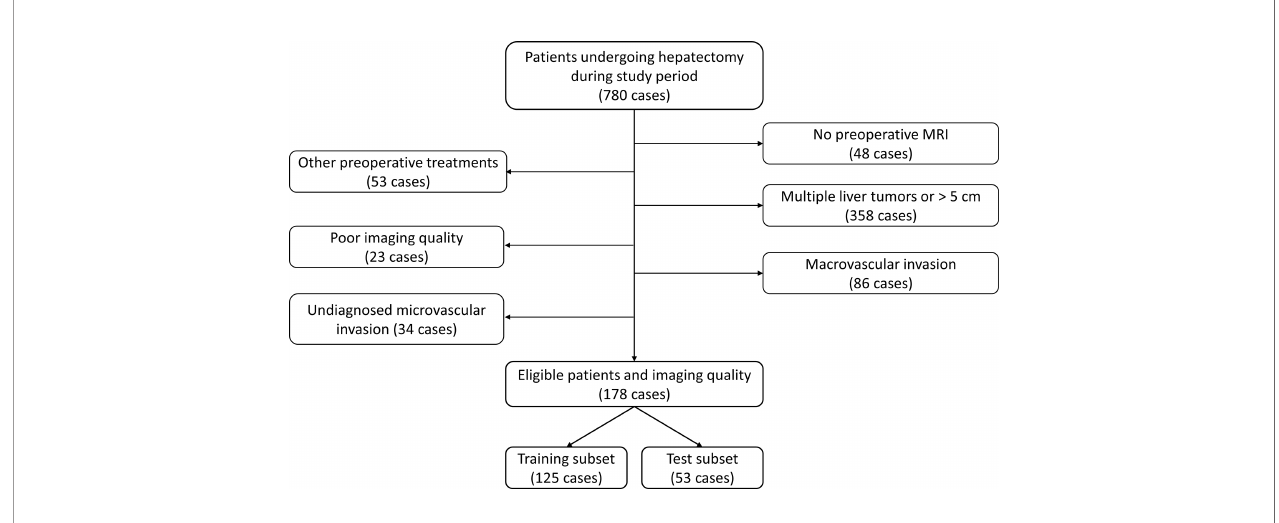
FIGURE 1 | Flowchart of patient selection in this study.